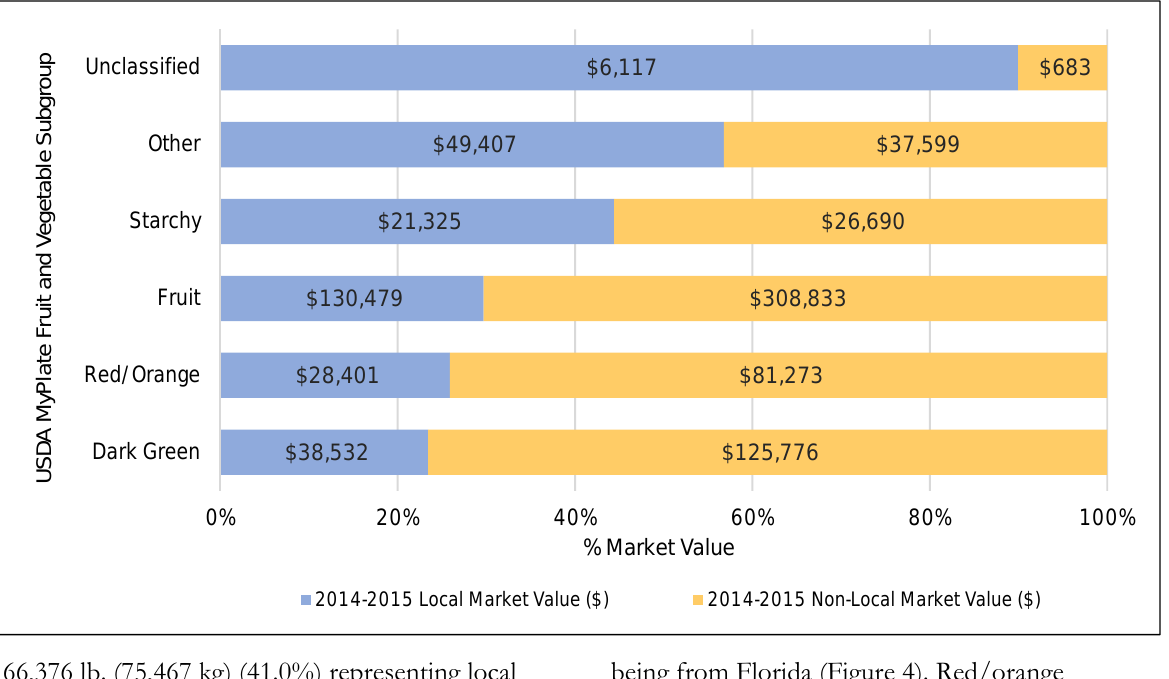
Figure 3. Local and Non-Local Fresh Food Purchases by Market Value and Percent, Sarasota County (Florida) School District, 2014–2015 (all currency in